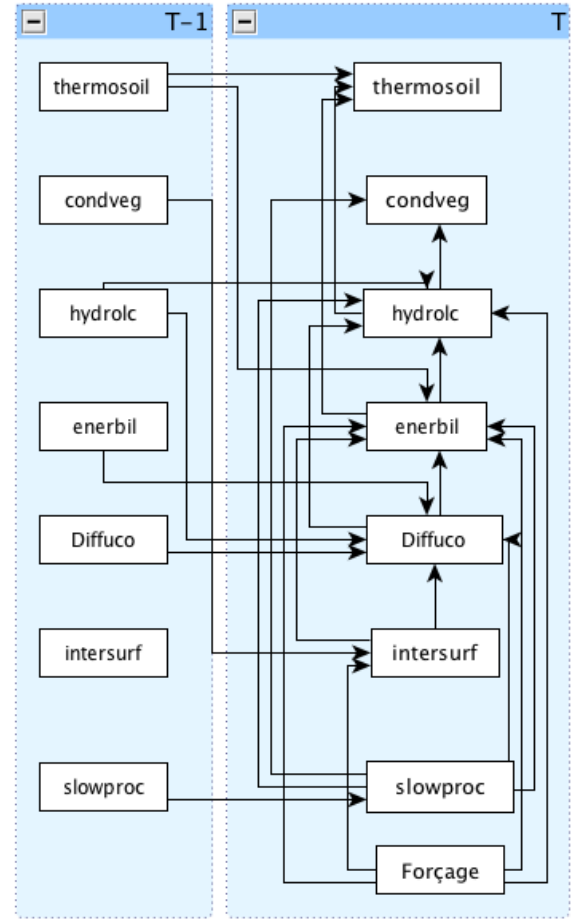
Figure A2. SECHIBA hyper-graph, showing general model dynam- ics. Source: Benavides Pinjosovsky